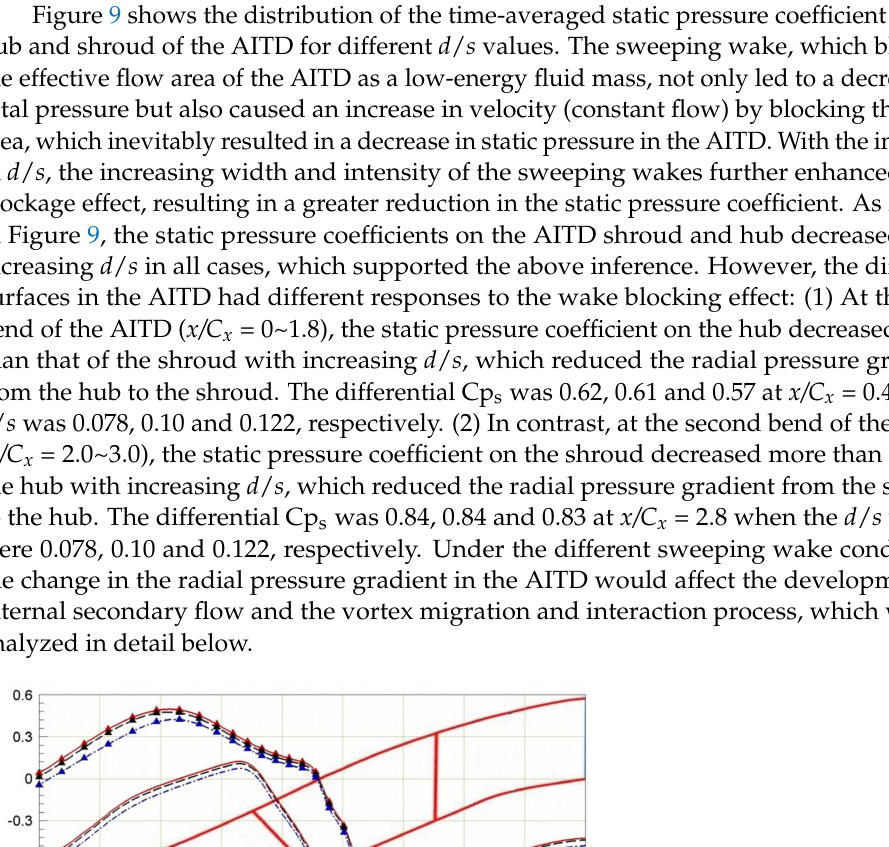
Figure 8. Circumferential distribution of turbulence intensity at the midspan of different passages inside the AITD.